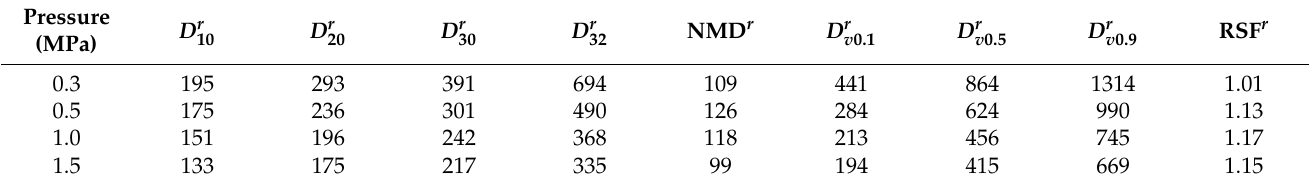
Table 1. Spray droplet diameters ( µ m) and relative span factor (average of three repetitions).